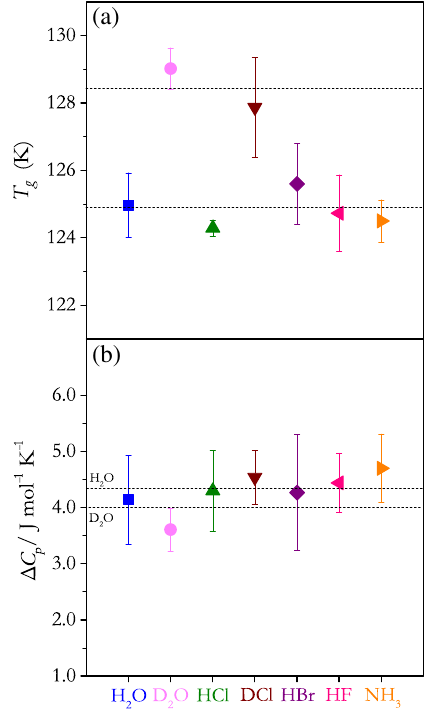
FIG. 8. (a) Onset glass transition temperature T and (b) heat g capacity change Δ c for eHDA at T for different isotopes or p g dopants. Black dashed horizontal lines describe the average value for the H 2 O and/or D 2 O samples.